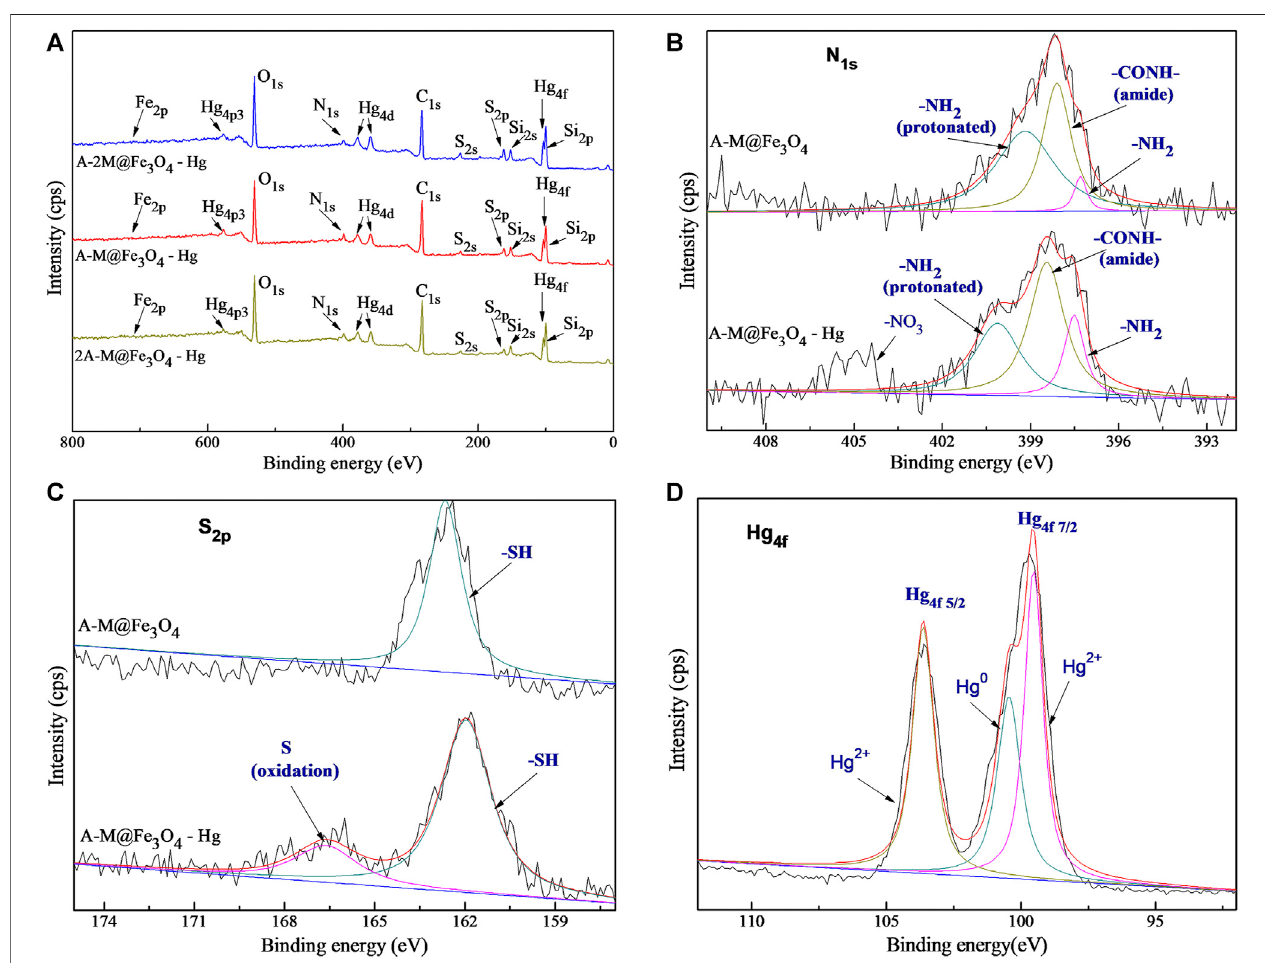
FIGURE5 |(A) The wide scanXPS spectraof bifunctional PSQ/CNTs magnetic compositesafter Hg(II) adsorption; high-resolution XPS spectra of (B) N 1s and (C)